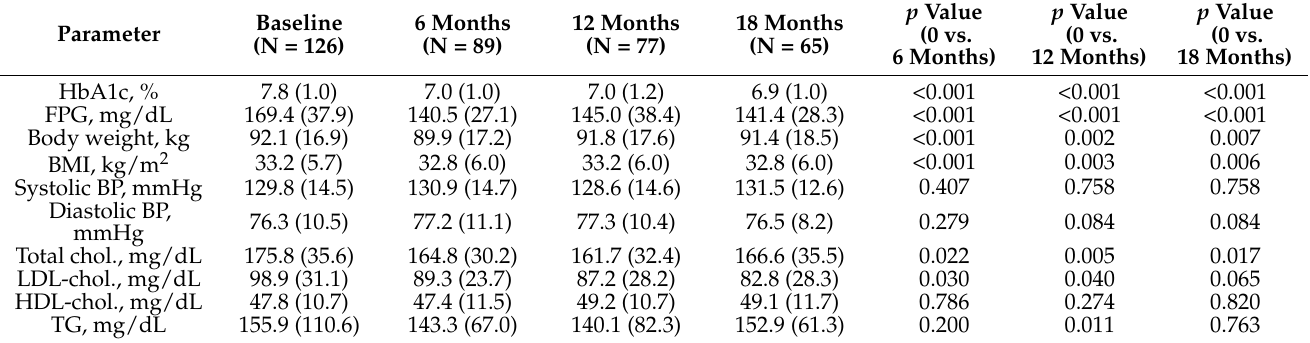
Table 3. Longitudinal comparisons of efficacy outcome measures for up to 18 months.